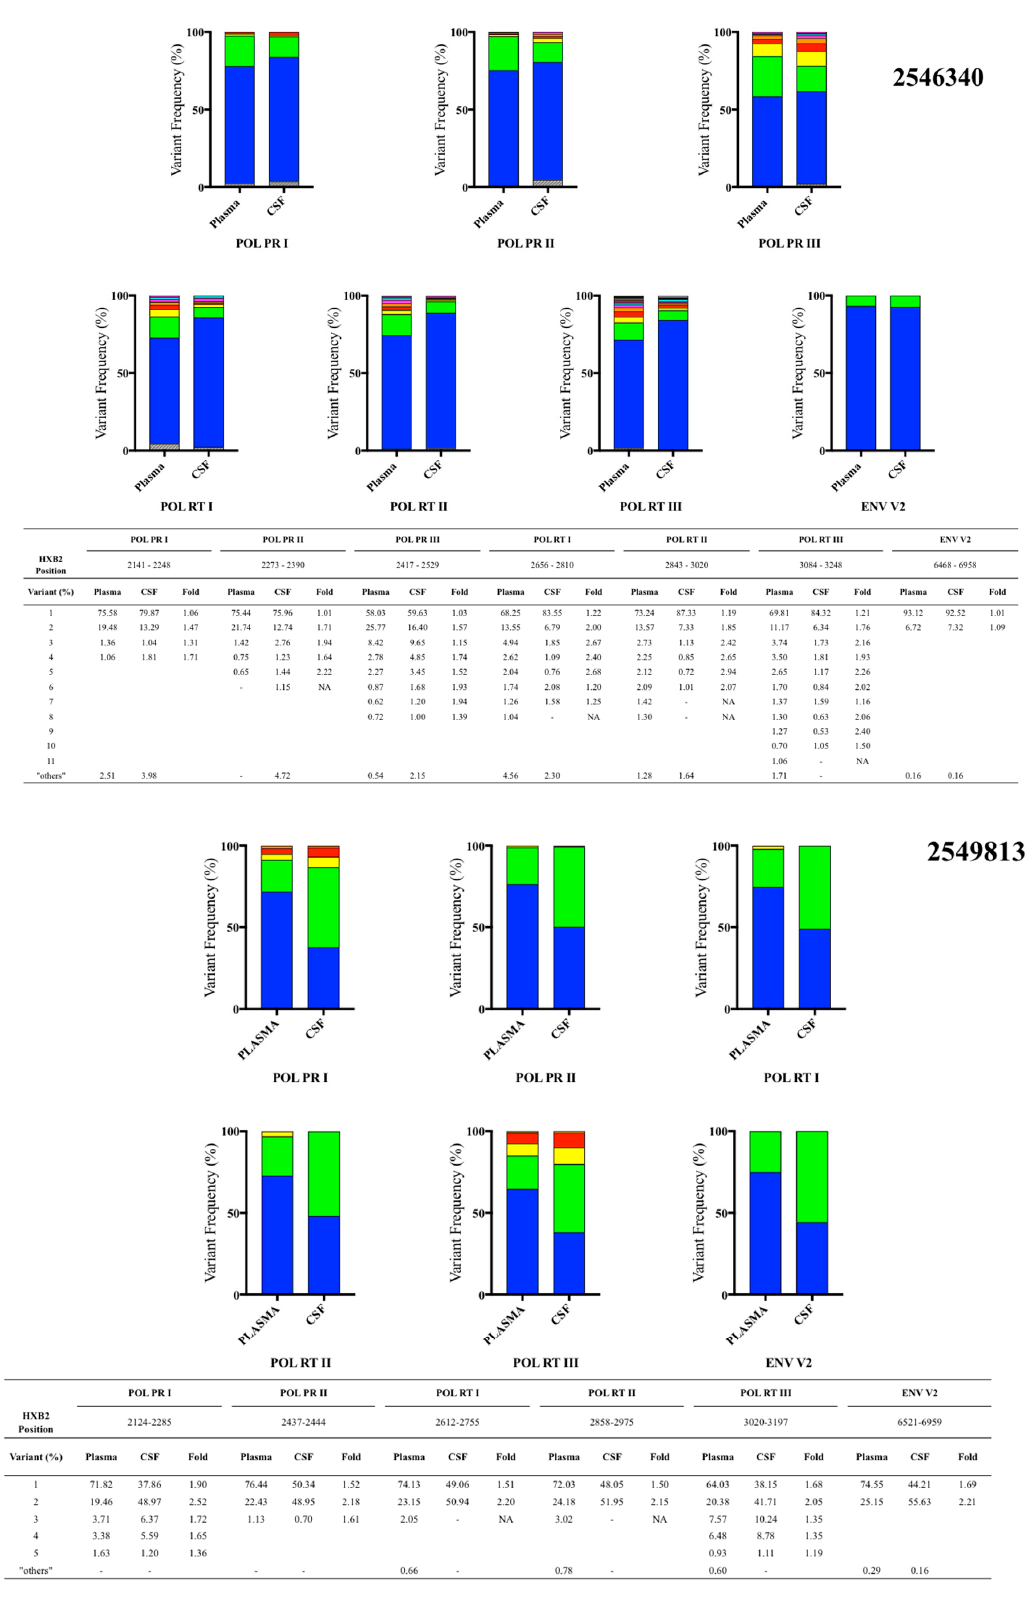
Figure 2. Proportions of plasma and CSF variants from three multiple transmitted/founder (T/F)-infected participants observed by next-generation sequencing platforms: participant 2547279, participant 2546340, and participant 2549813.